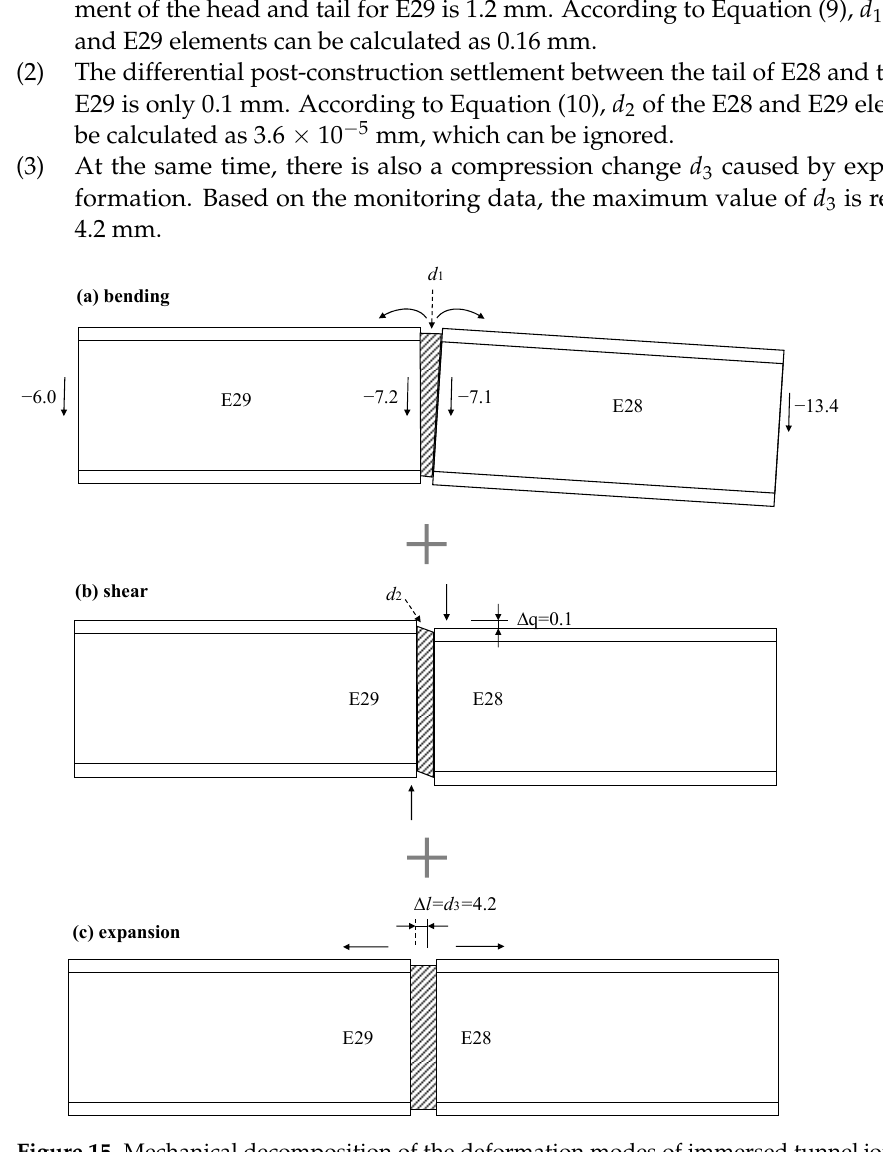
Figure 15. Mechanical decomposition of the deformation modes of immersed tunnel joint between E28 and E29 elements.